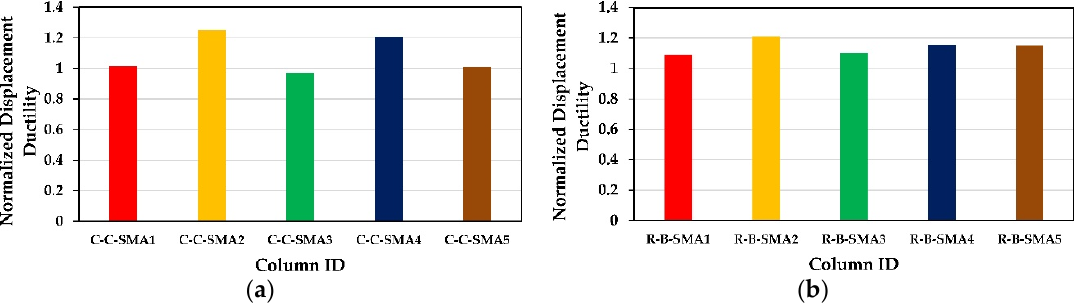
Figure 10. Normalized displacement ductility: ( a ) Columns of Group1; ( b ) columns of Group2.